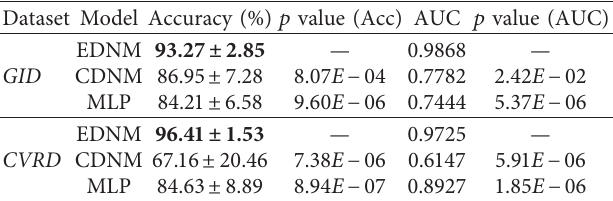
Figure 9: Evolution of neuronal morphology on CVRD problem. Table 8: Results of accuracy, p value, and AUC for EDNM, CDNM, and